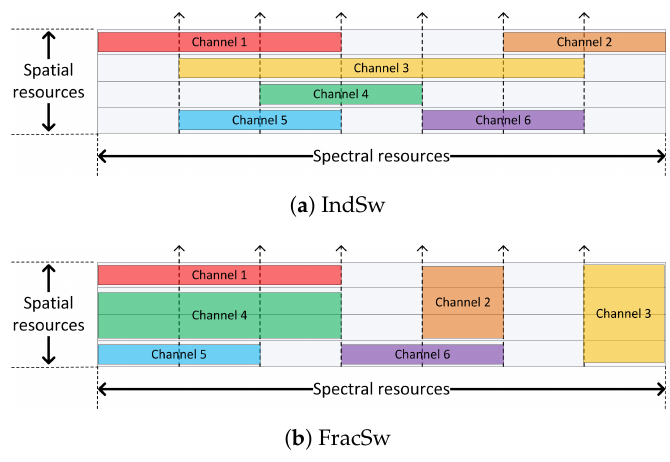
Figure 1. Resource allocation in an SS-FON